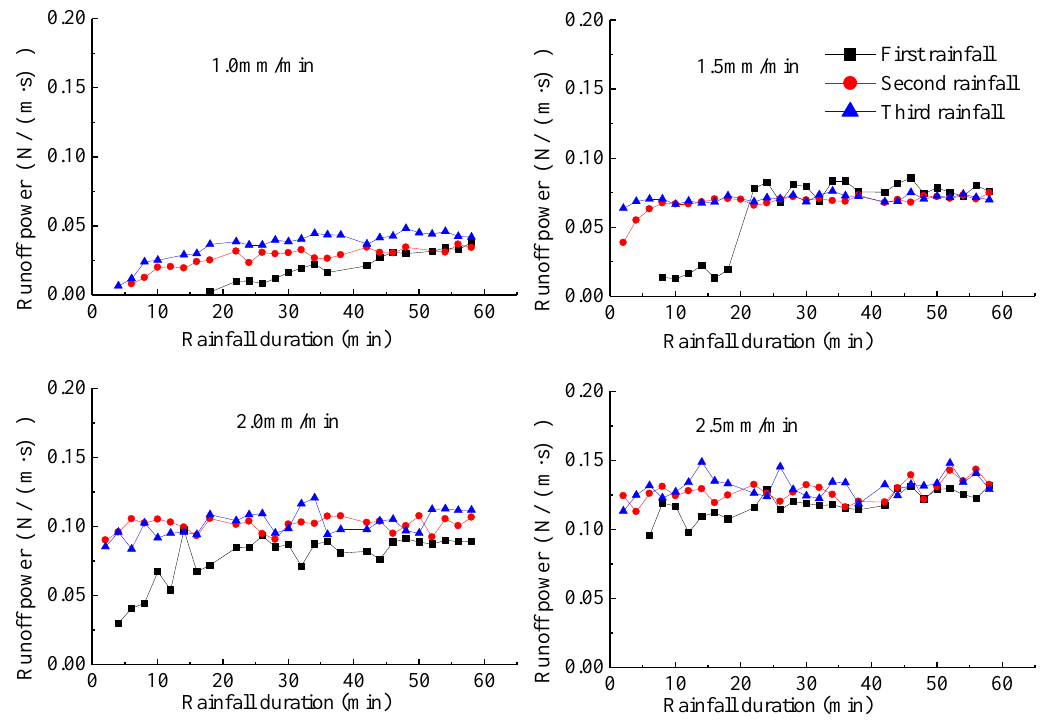
Figure 18. Linear fitting relationship between average runoff shear stress and rainfall density of the loess slope.